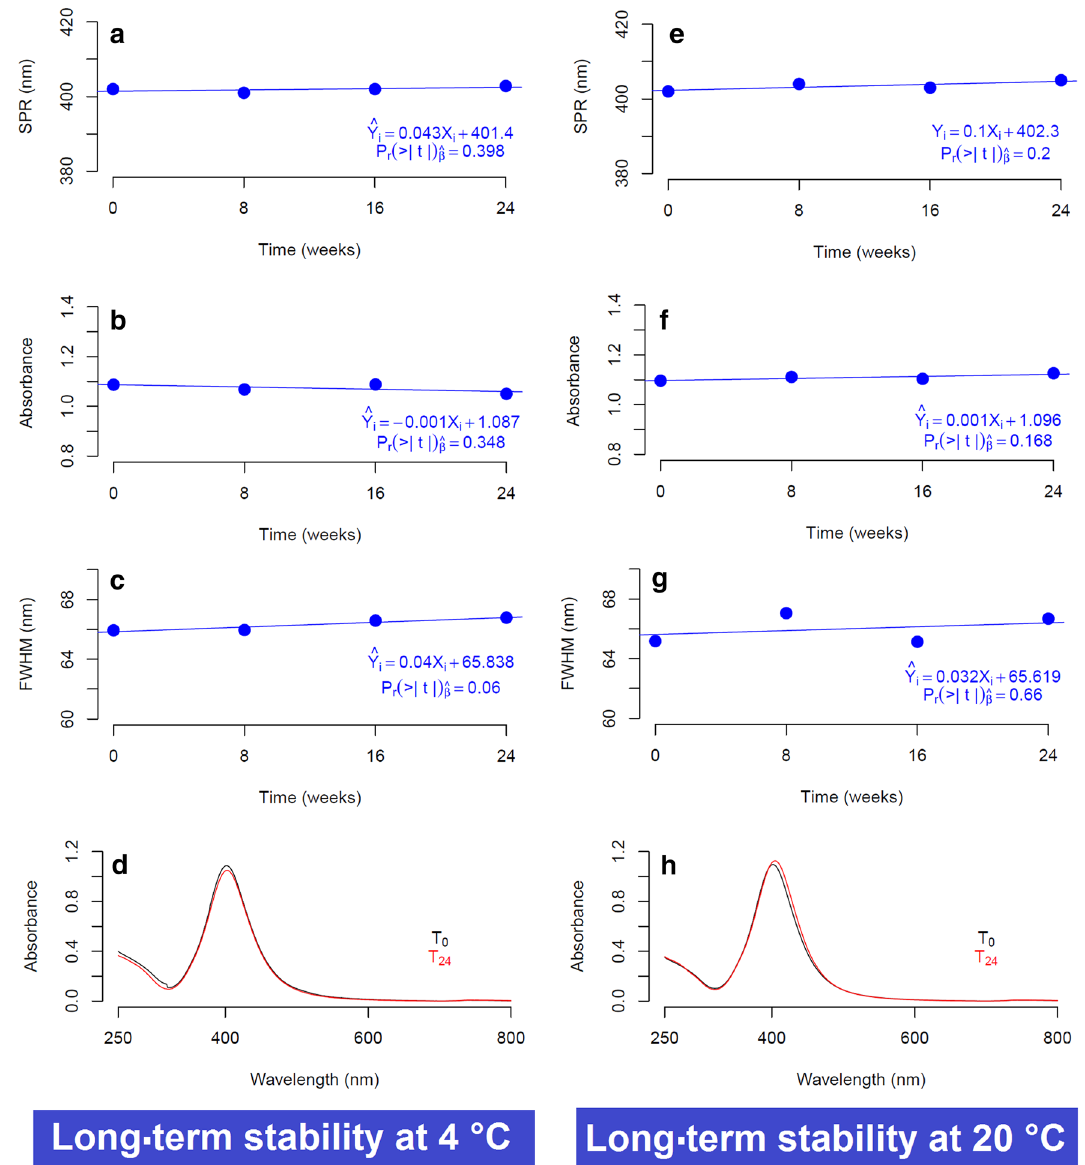
Figure 8. Long-term stability of the sub-15 nm AgNPs stored at different temperature conditions (4 °C and 20 °C). The images illustrate the OLS models of each optical property of the sub-15 AgNPs. The model OLS and (cid:31) β t-Student test performed to the slope ( ) is present in all the